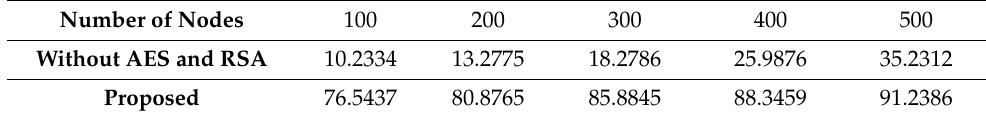
Table 3. Execution times without AES and RSA and proposed mechanism.